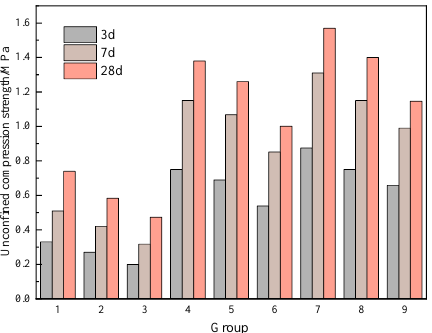
Figure 7. The unconfined compressive strength of lightweight CLSM.